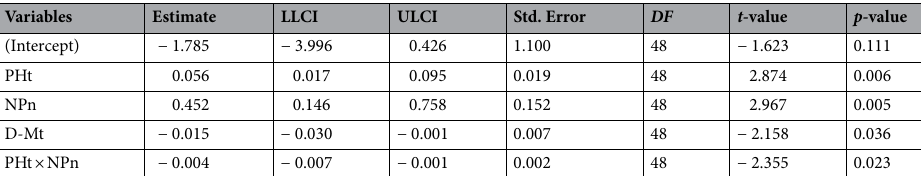
Table 4. Parameters of generalized linear mixed-effects models (Gaussian fit and identity link) testing the effects of plant height (PHt), number of panicles (NPn), period from emergence to maturity (D-Mt) on the variation of grain yield of quinoa grown under field conditions of the Sahara Desert. DF : degrees of freedom, LLCI and ULCI: lower and upper limit of the confidence interval, respectively.